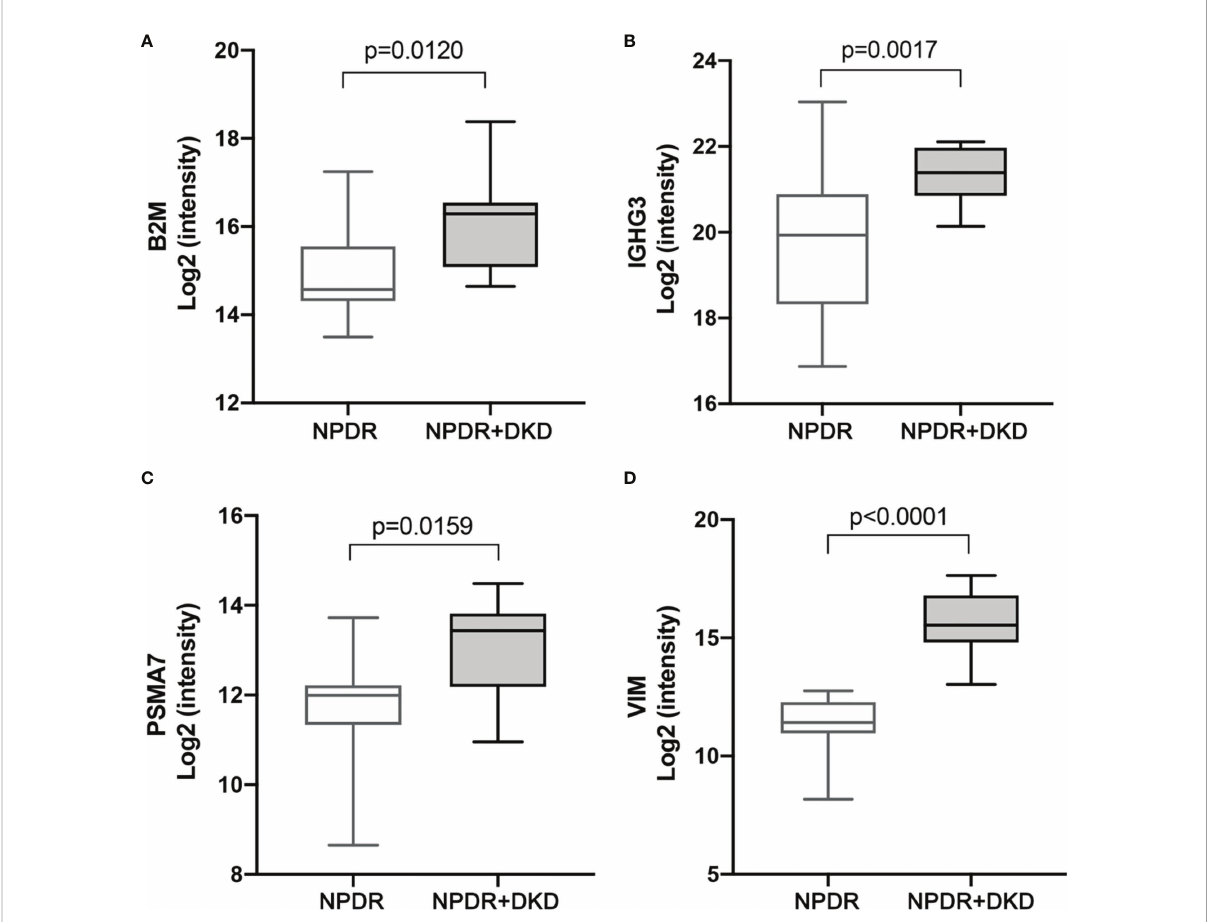
FIGURE 6 Expression levels of target protein candidates in the plasma of NPDR+DKD vs. NPDR. (A-D) Expression levels of B2M, IGHG3, PSMA7 and VIM between the NPDR+DKD and NPDR groups based on proteomics data. (n = 15 in NPDR group; n = 9 in DKD